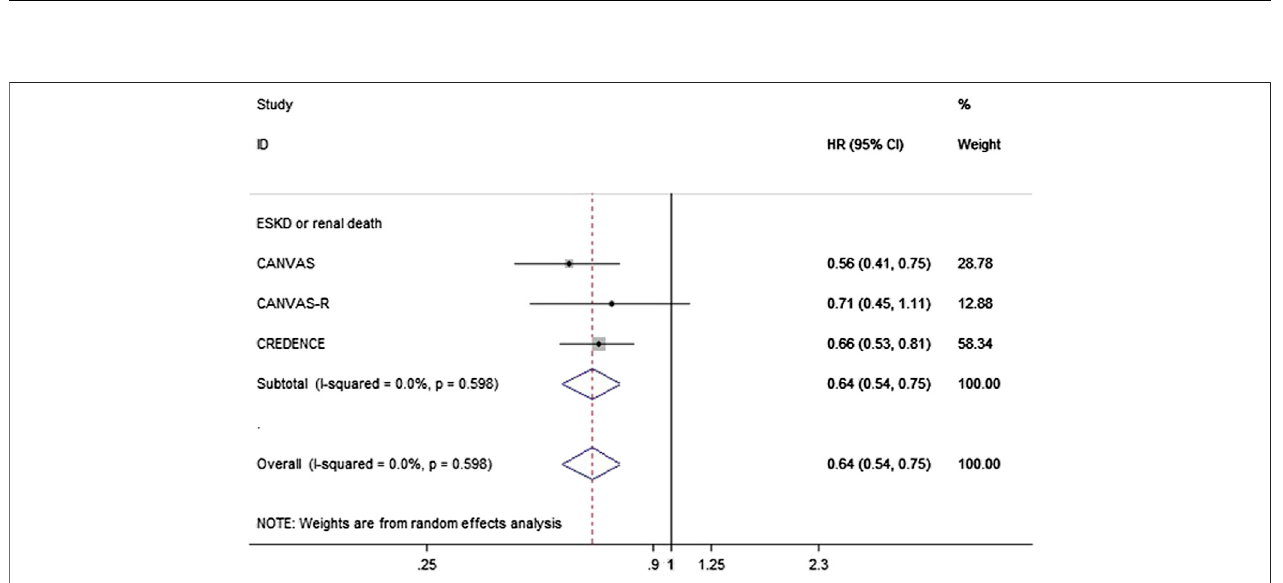
FIGURE 4 | Forest plot of the effects of canagli fl ozin on the composite of ESKD or renal death of the T2DM participants.